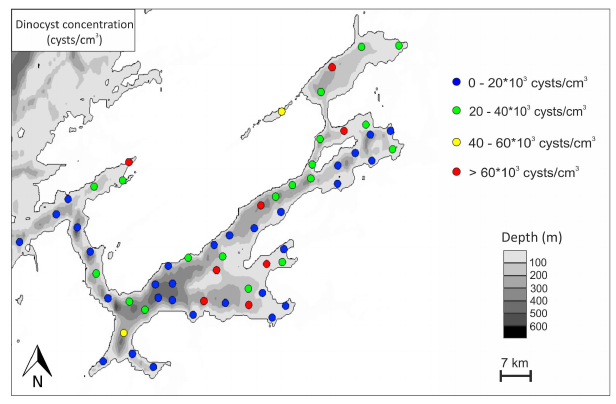
Fig. 6. Dinocyst concentrations (cystscm − 3 ) in surface samples in the